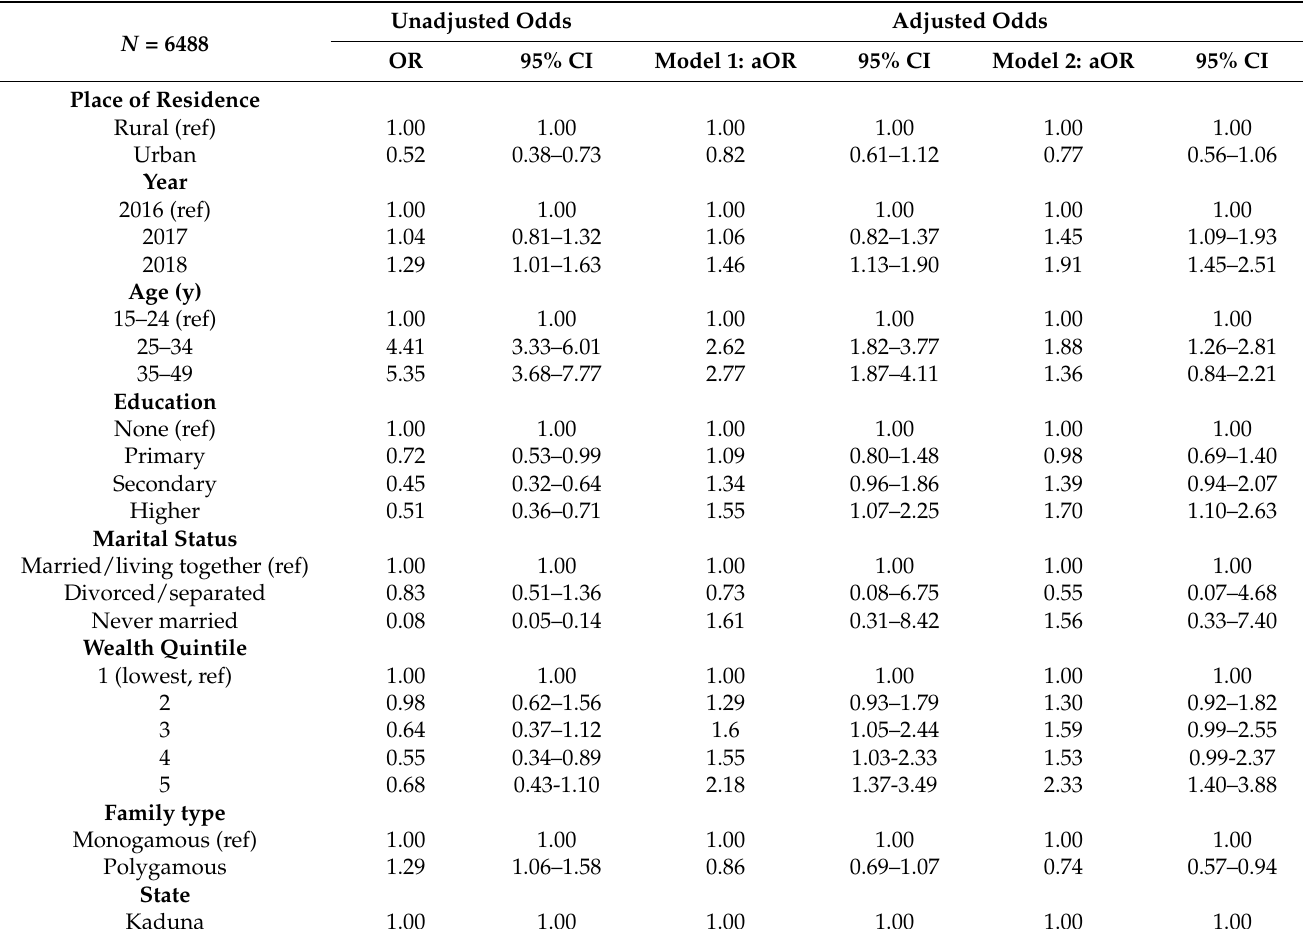
for sociodemographic characteristics (Table 3, Model 1) and in the final model (Table 3, Model 2), these were no longer statistically significant. Table 3. Weighted crude and adjusted odds of long-acting reversible contraceptive use